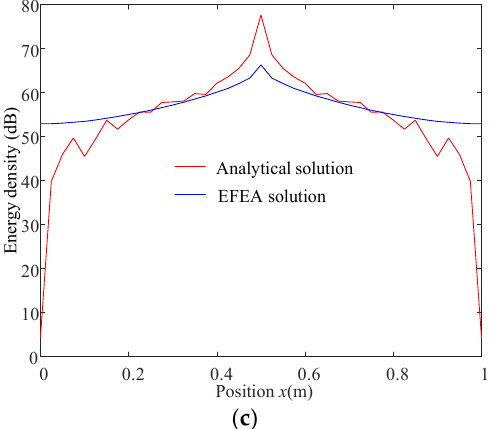
Figure 5. Energy density distribution for a plate with FFLD treatment under various excitation frequency ( η 2 = 0.8, h 2 = 0.002 m). ( a ) f = 5 kHz. ( b ) f = 8 kHz. ( c ) f = 10 kHz.